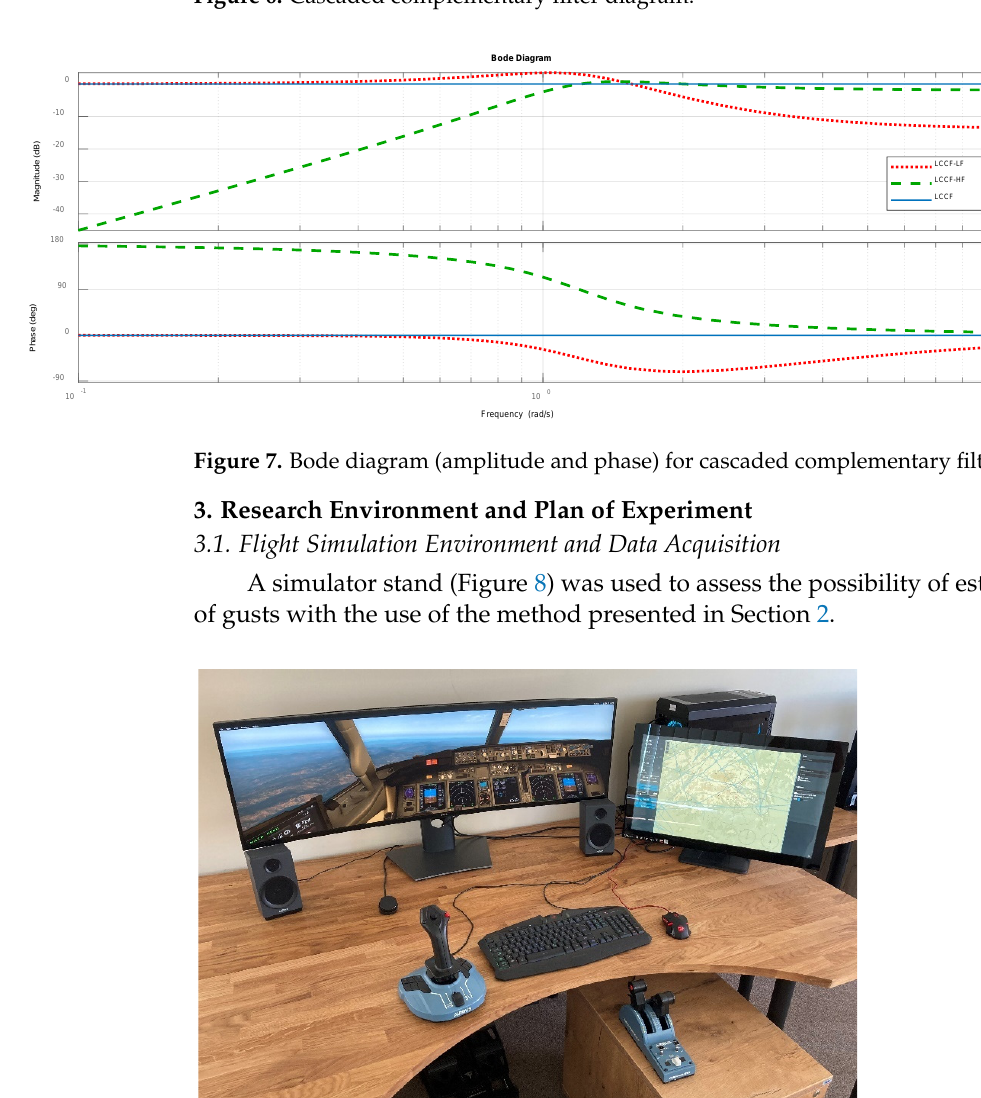
Figure 9. Block diagram of the stand for flight simulation and data acquisition. The flight simulation was made using the X-Plane 11 software version certified for professional use. For research purposes, layers of programmatically generated atmospheric gusts were introduced in the simulation environment. The flight parameters of one of the most popular medium-range narrow-body aircraft (B737-800) were recorded. The simulation was performed using a realistic model of this type of aircraft (Figure 10), which very accurately reflects its dynamic properties and operational functions. The analysed estimation algorithms assume the use of data available from the following on- board systems: ADIRU, GPS and flight controls systems. ( A )